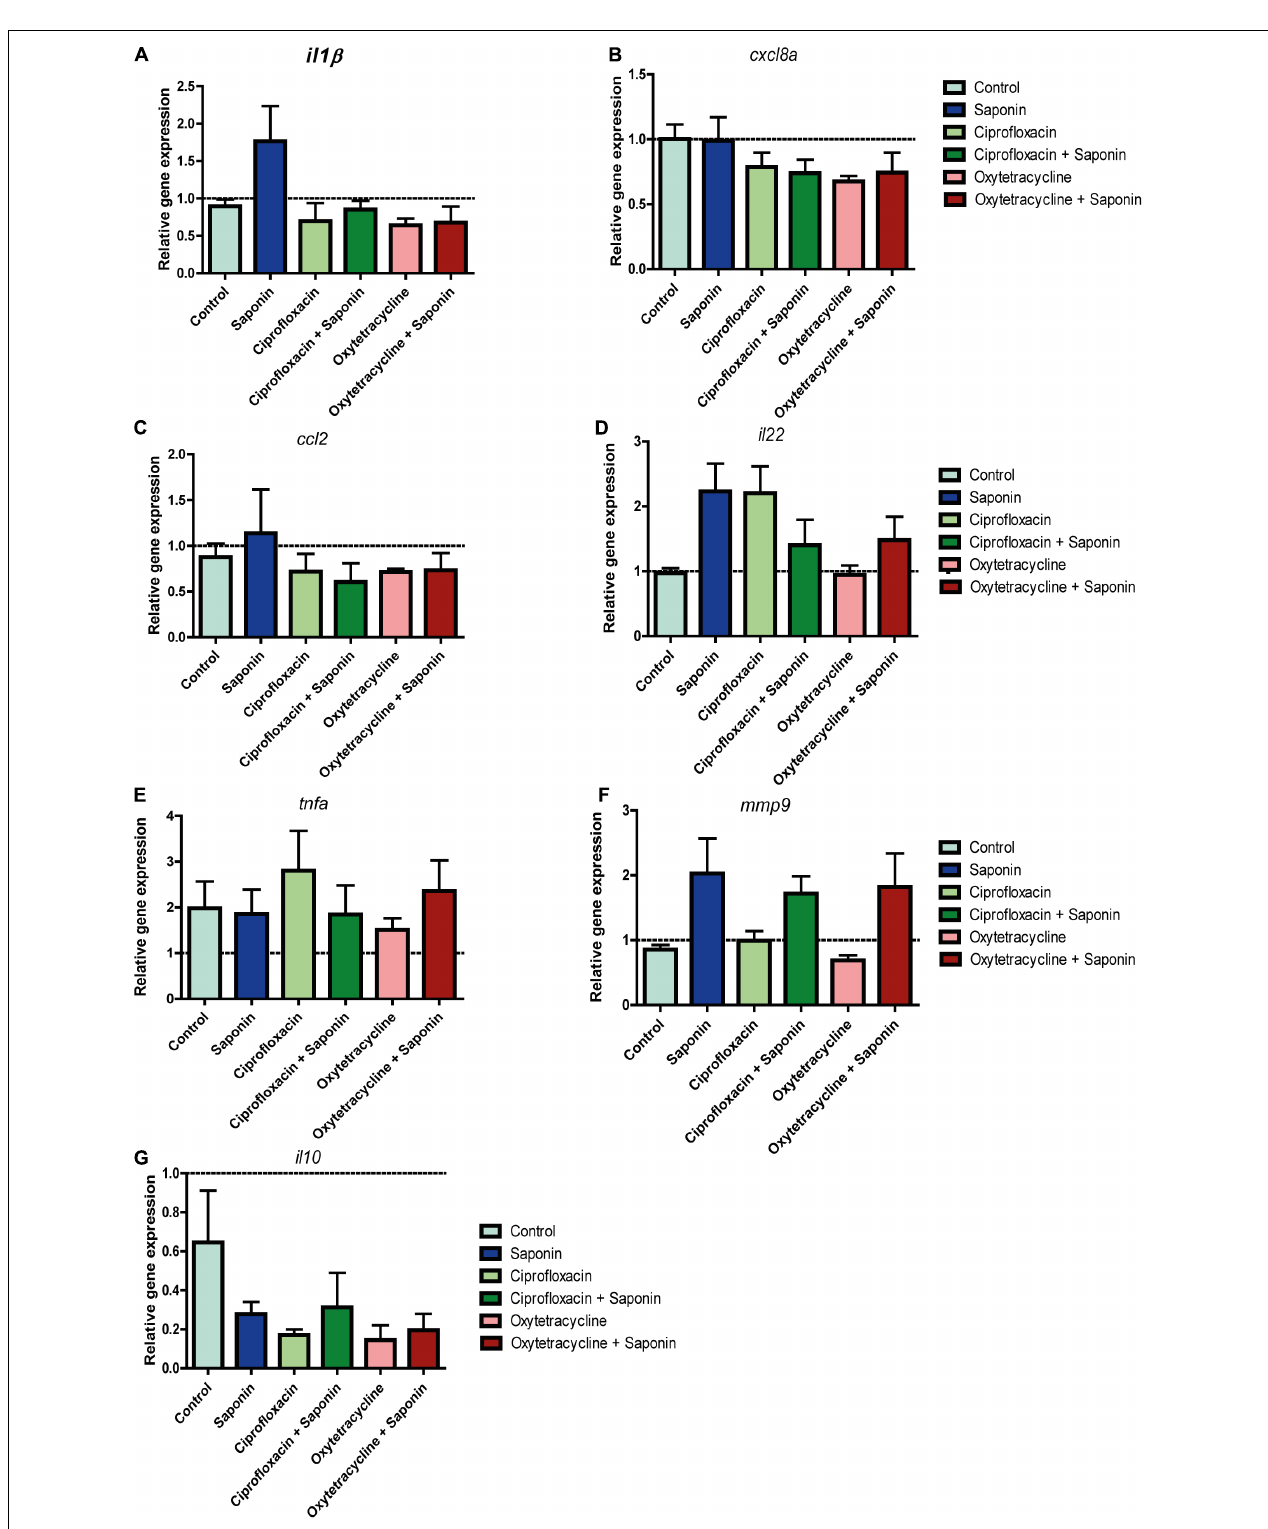
FIGURE 5 | Relative gene expression of antibiotic/saponin-treated zebrafish. At 72 h after exposure (9 dpf) zebrafish larvae were euthanized and 5 whole zebrafish were pooled for each sample. After RNA extraction and cDNA synthesis, qPCR was performed for the following cytokines: (A) il-1 β , (B) cxcl8a, (C) ccl2, (D) il22, (E) tnfa (tnf α 2), (F) mmp9, and (G) il10. ( n = 4 pools of 5 larvae/treatment, one way ANOVA Kruskal-Wallis test with Dunn’s Multiple comparison Post-Test, mean ± SEM).